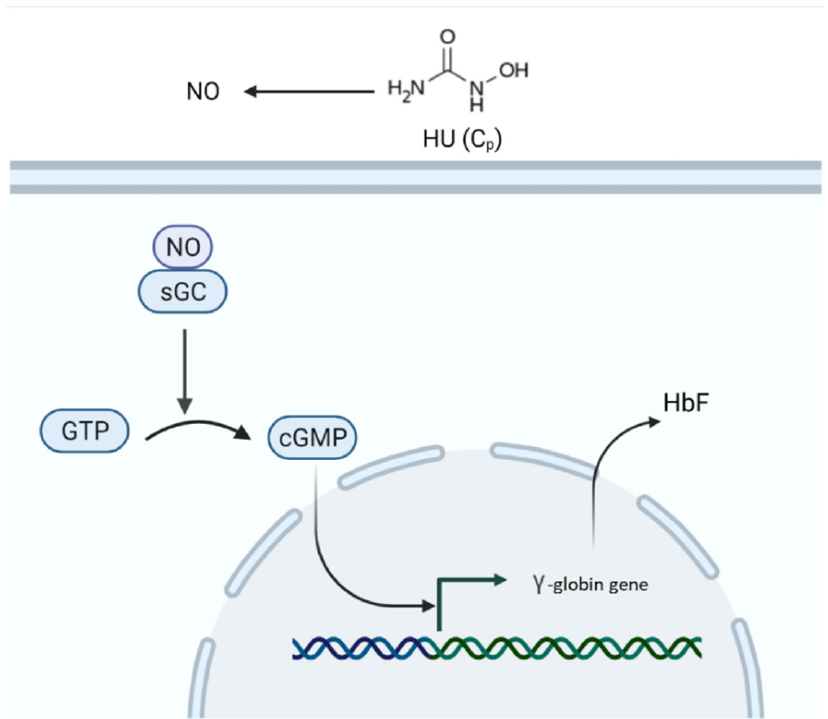
Figure 7. Hydroxyurea-mediated activation of fetal hemoglobin. HU, hydroxyurea; NO, nitric oxide; sGC, soluble guanylyl cyclase; GTP, guanosine triphosphate; cGMP, cyclic guanosine monophosphate; HbF, fetal hemoglobin.